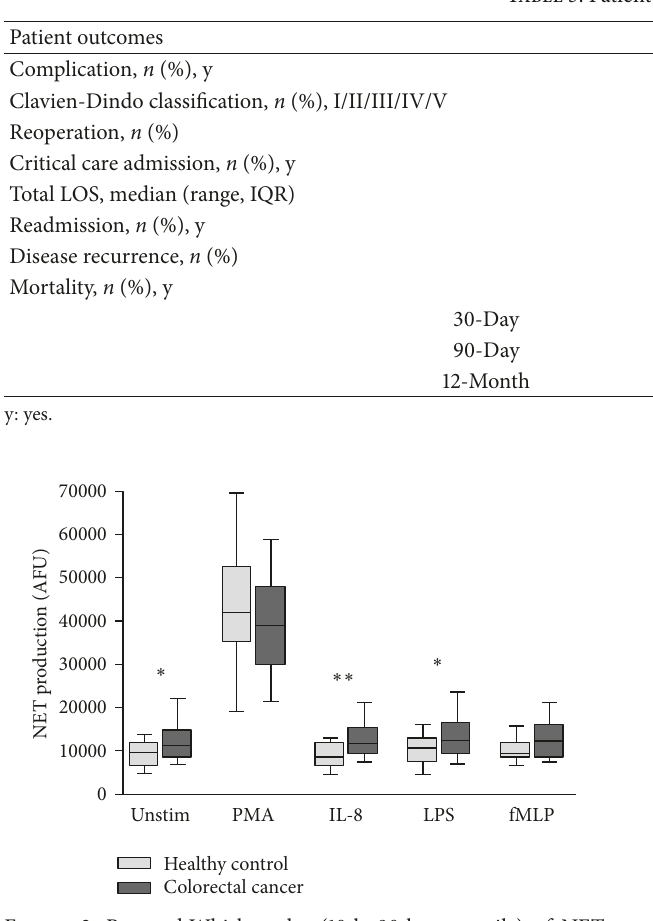
Figure 2: Box-and-Whisker plot (10th–90th percentile) of NET production in healthy control subjects ( 𝑛 = 20 ) and patients with colorectal cancer ( 𝑛 = 45 ) in response to no stimulant (Unstim), PMA, IL-8, LPS, and fMLP. Statistical significance, measured by Mann–Whitney 𝑈 test, is denoted by ∗ 𝑝 < 0.05 and ∗∗ 𝑝 < 0.01 .